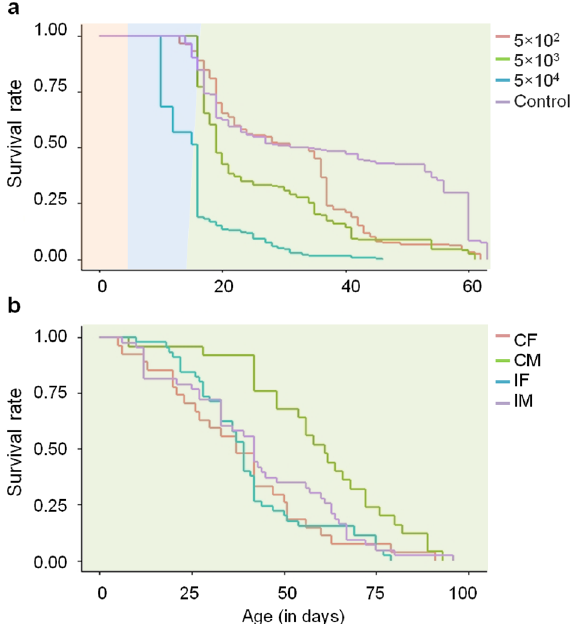
Figure 4. ( a ) Kaplan–Meier survival curves of D. suzukii (SWD), shown as complete lifespan from larval stage (day 0–6, orange field) to pupal stage (day 7–19, blue field) up to eclosion and death in adult stage (green field). Second instar larvae were either exposed to 5 × 10 2 spores (red line, replicates/number (R/N) = 4/180), 5 × 10 3 spores (green line, R/N = 4/204), 5 × 10 4 spores (turquoise line, R/N = 7/264) or sterile water as control (purple line, R/N = 11/408). Log rank test: χ 2 = 534, DF = 3, P < 0.001. ( b ) Kaplan–Meier survival curves of adult SWD inoculated with T. suzukii 3 days after emergence. Separated male and female SWD could either feed on sterile water as control (CF = control female, red, replicates/number (R/N) = 4/27; CM = control male, green, R/N = 4/25) or a spore suspension of 3 × 10 5 T . suzukii spores (IF = inoculated female, turquoise, R/N = 4/45; IM = inoculated male, purple, R/N = 4/43). Log rank test: χ 2 = 13.1 DF = 3, P = 0.004.